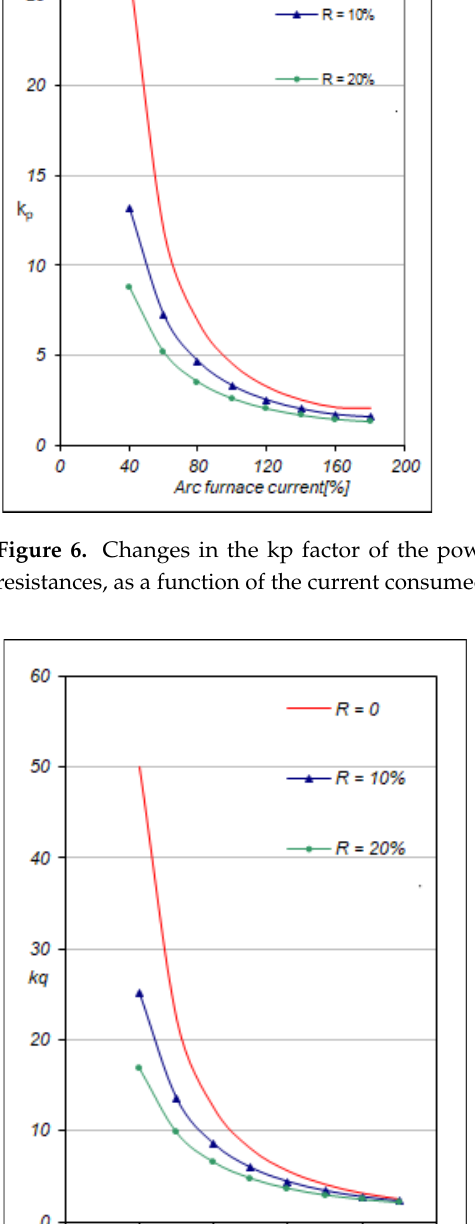
Figure 8. Simplified single-phase equivalent diagram of the arc device, omitting the resistance in the electric arc supply line. The value of the current in the circuit during operation—at a certain value of U Arc , is determined from the formula: jX UU I ARCSV − = (42) the theoretical operational short-circuit current (electrode short-circuit with the charge) is determined by the relationship: jXU I (43) Active power, disregarding the losses in the supply circuit ( R = 0), will be the power released in the arc.